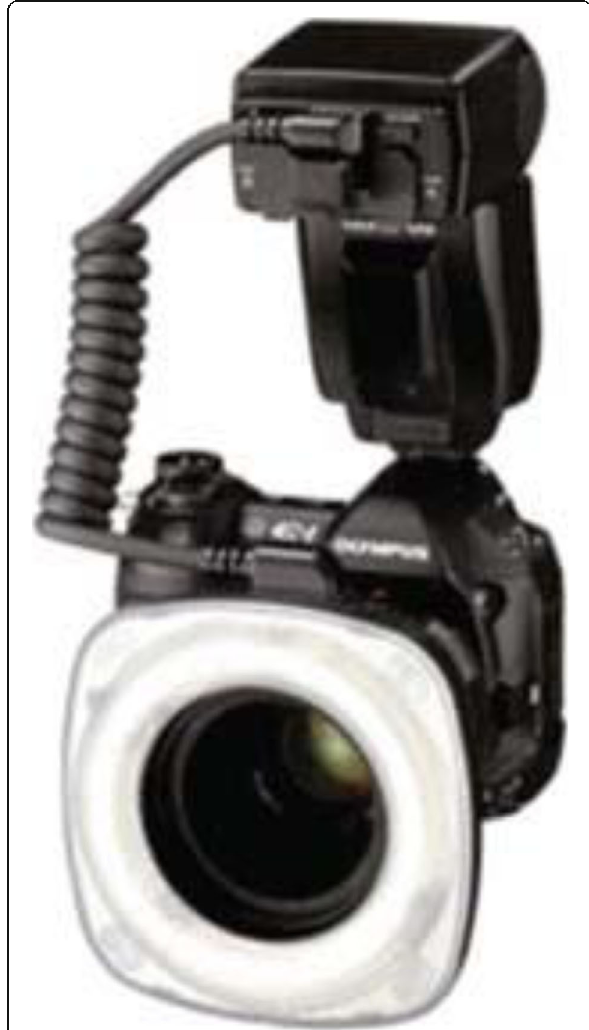
Fig. 1 The ring flash for the camera. Reprinted with permission from Ahmad I, General Dental Practitioner, The Ridgeway Dental Surgery, 173 The Ridgeway, North Harrow, Middlesex, HA2